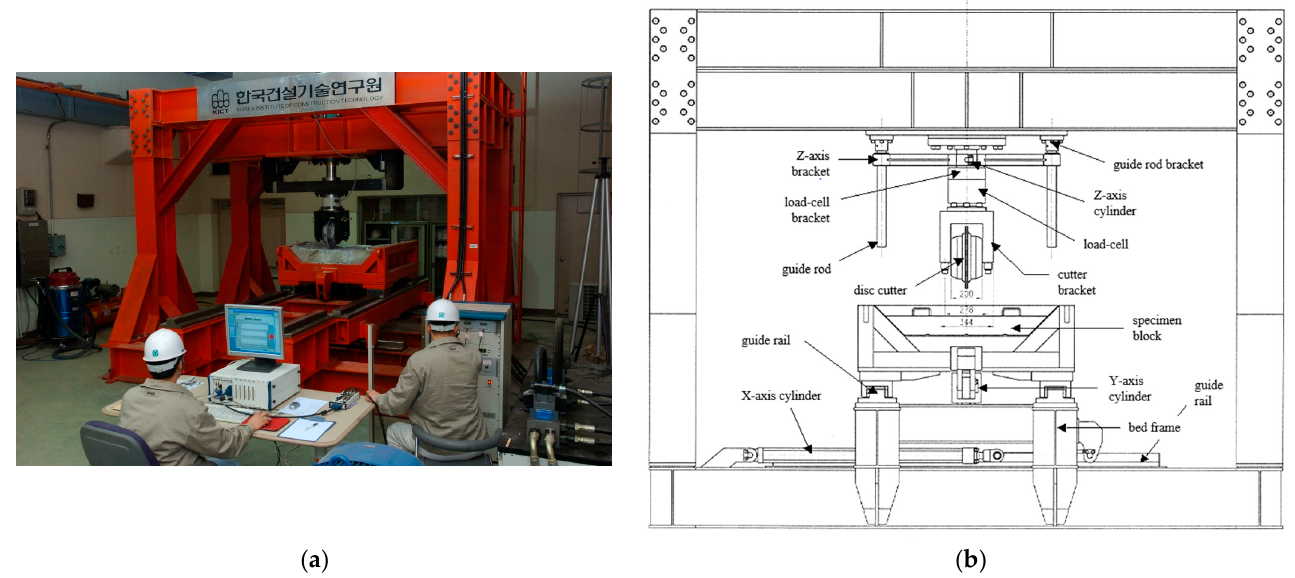
Figure 1. The linear cutting machine system [4]: ( a ) photo; ( b ) schematic drawing.